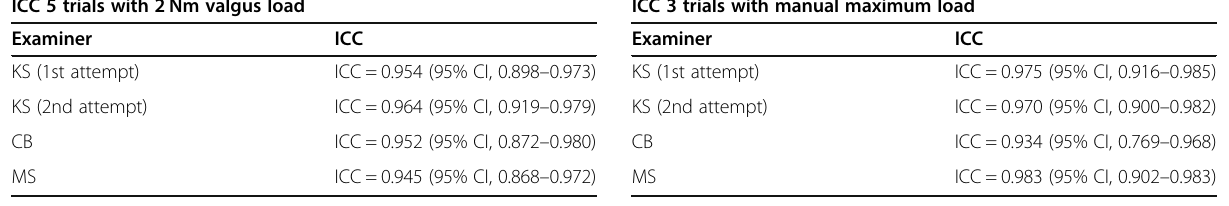
valgus load (elbows pooled) ICC 5 trials with 2 Nm valgus load